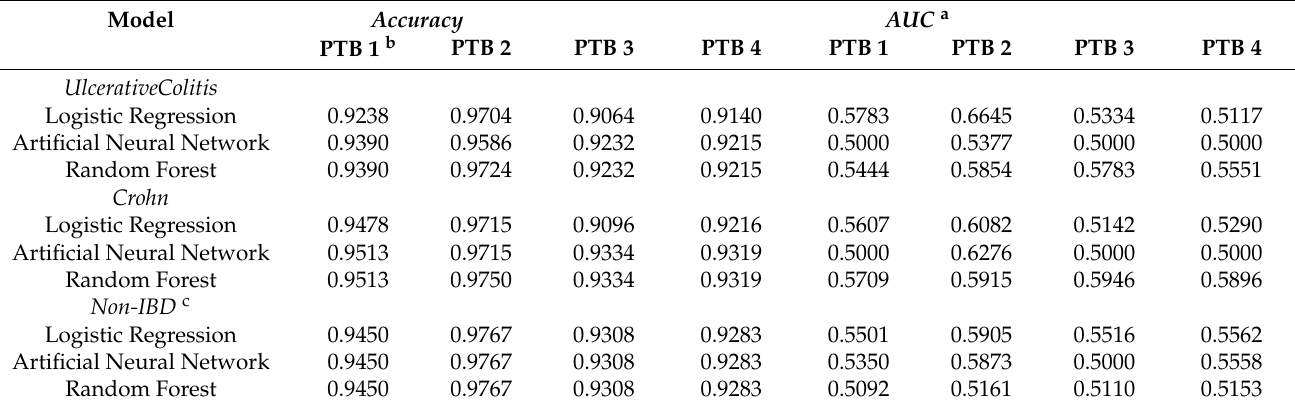
Table 1. Model Performance.